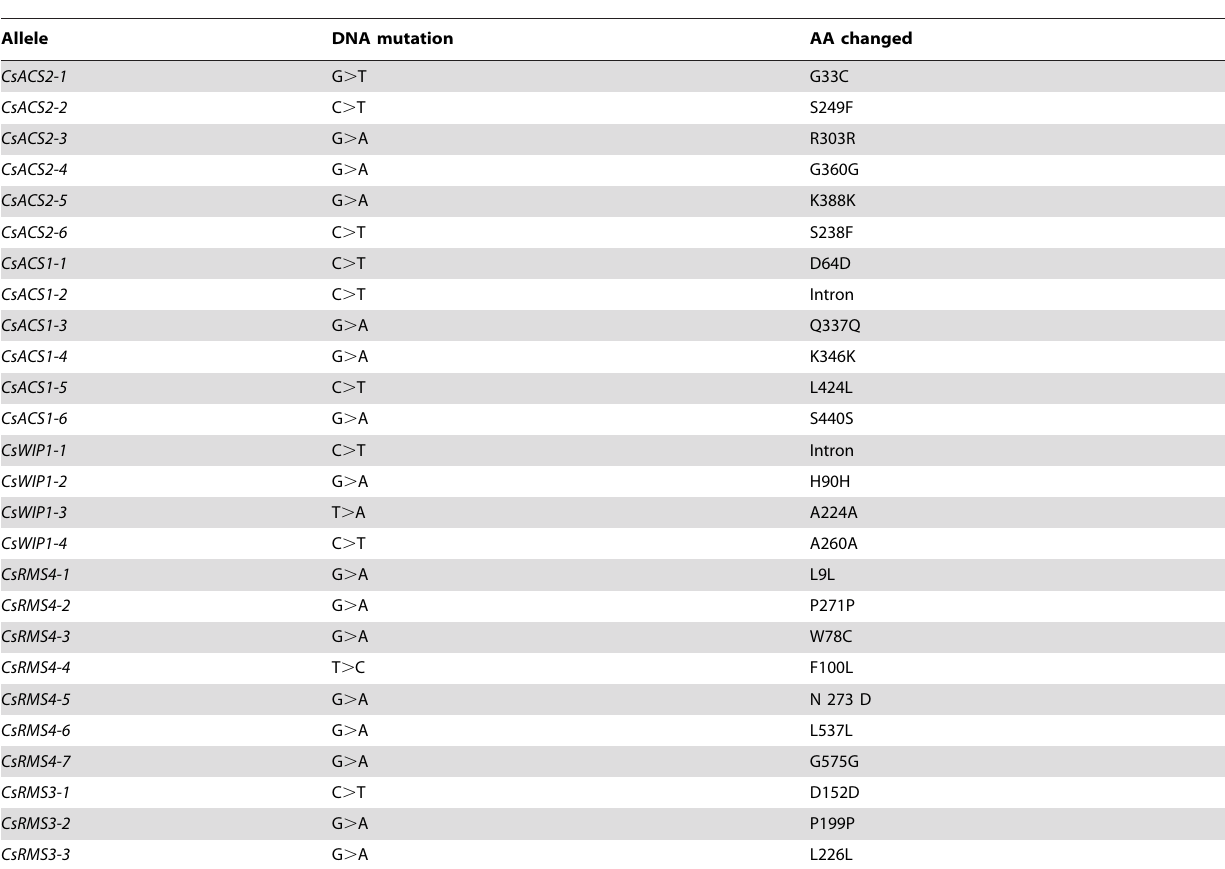
Table 4. Nature of mutations found in the cucumber TILLinG population.